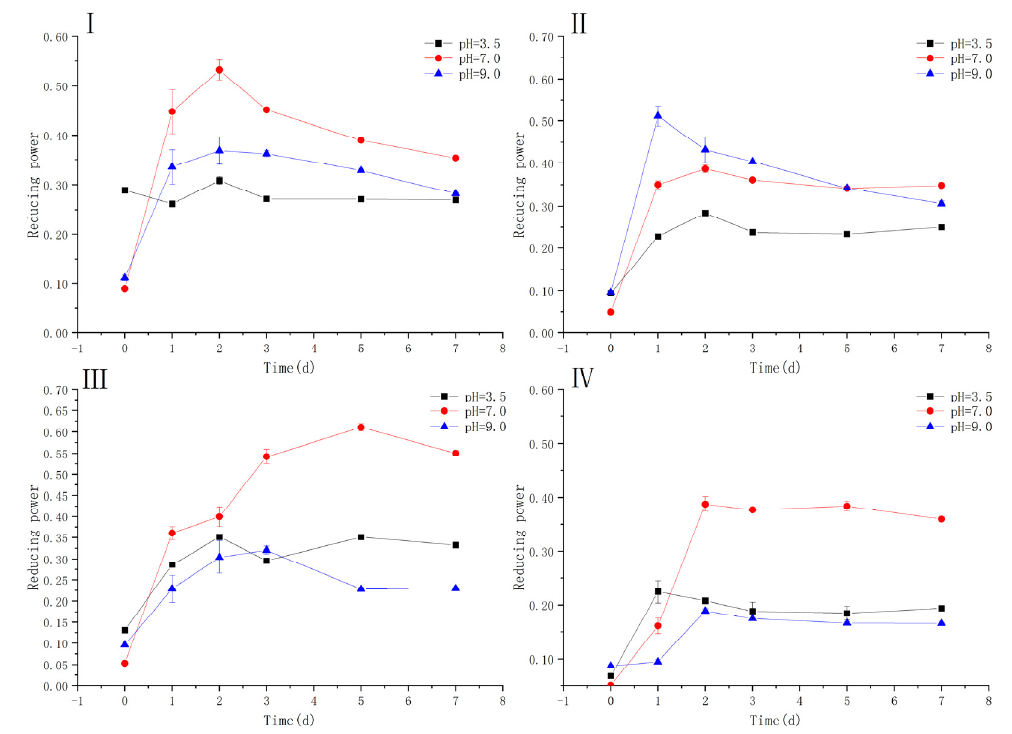
Figure 2. The Reducing power of autoxidation products of ( I ) Catechin ( II ) Epicatechin ( III ) Caffeic acid ( IV ) Chlorogenic acid in various values of pH.